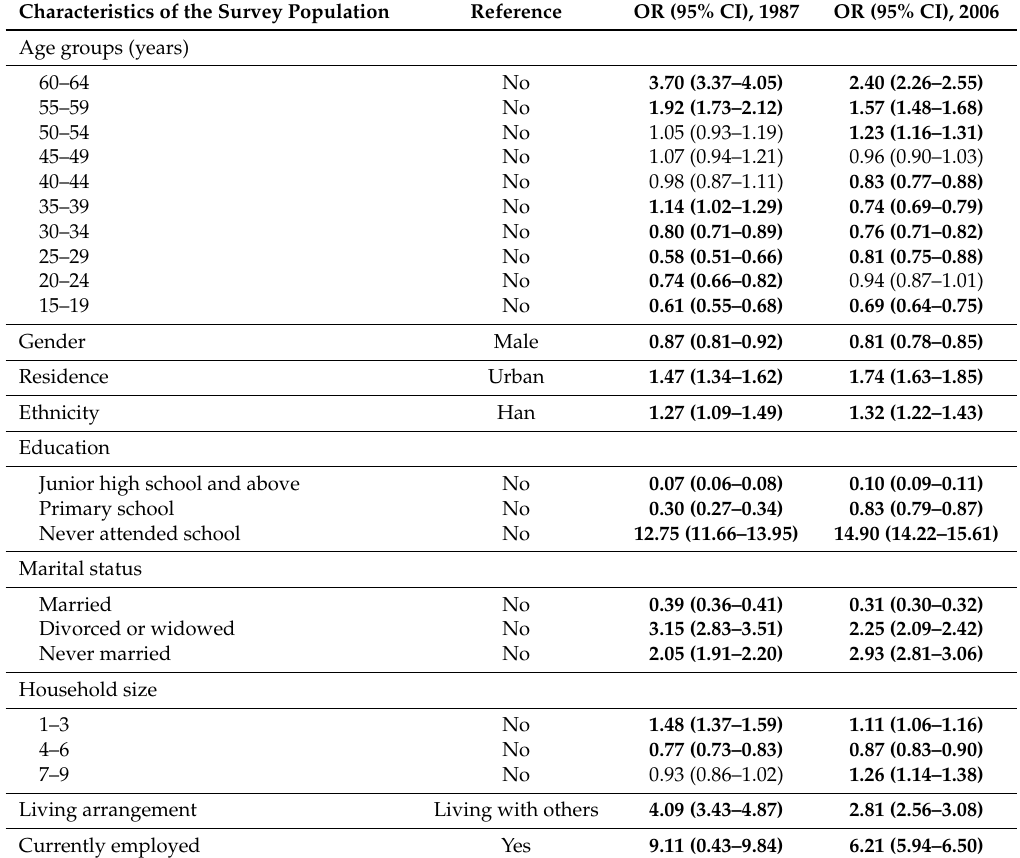
Table 3. Crude odds ratios of multiple disabilities (yes/no) according to the characteristics in the study. Characteristics of the Survey Population